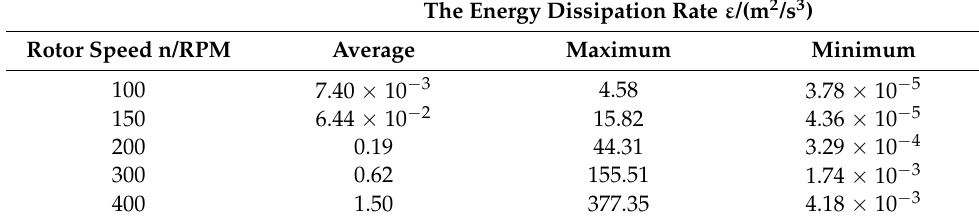
Table 2. Rotor speeds (n) and energy dissipation rates ( ε